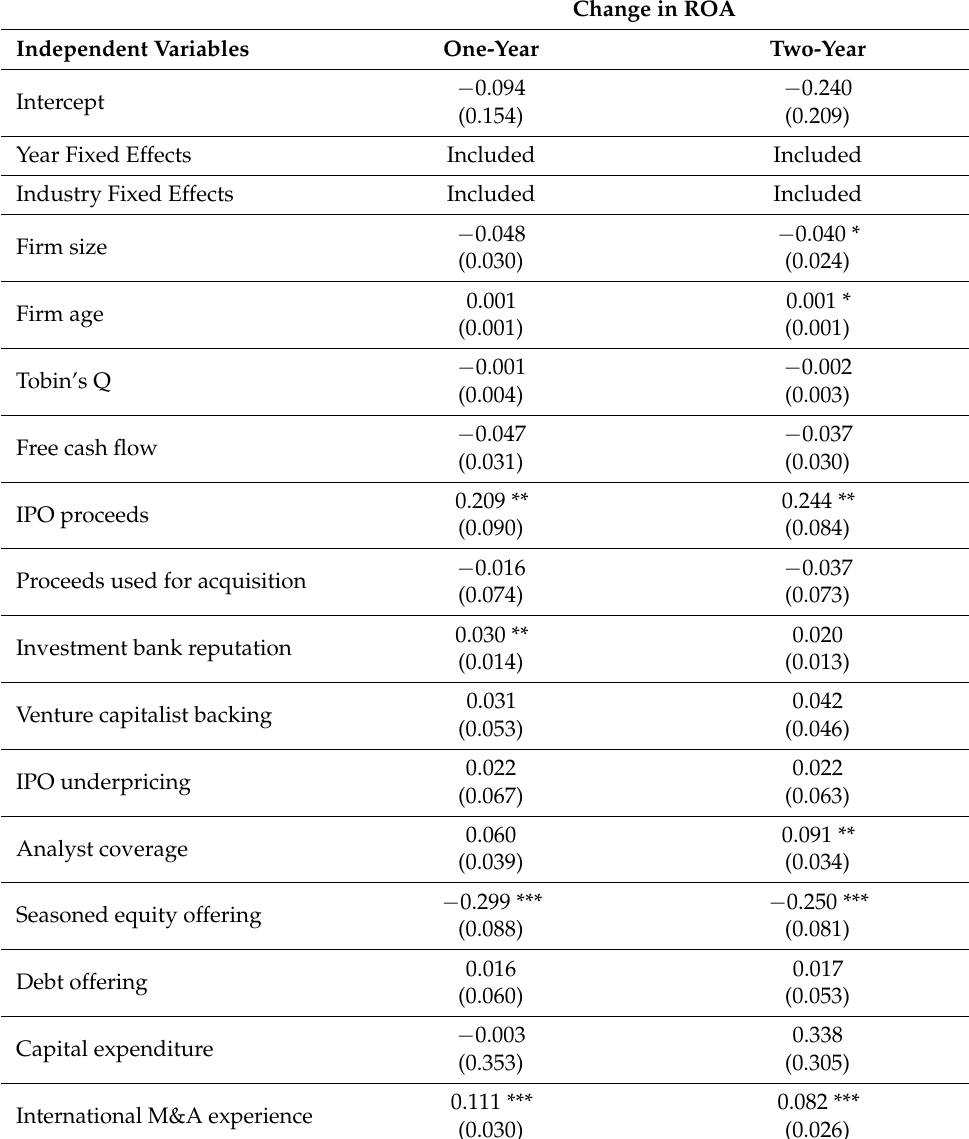
Table 5. Performance Following International